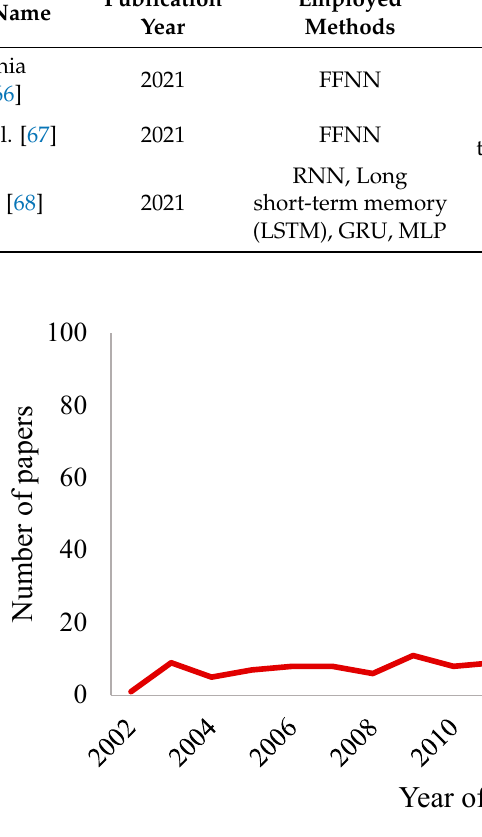
Figure 4. Number of published papers employing soft computing methods in seepage simulation, extracted from Scopus.